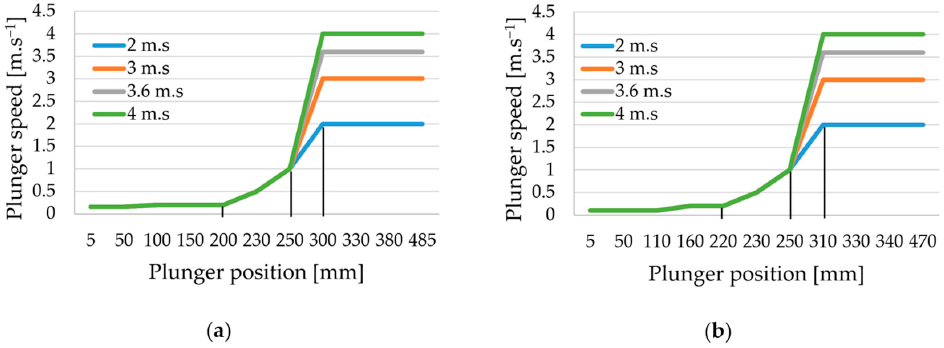
Figure 2. The dependence of the plunger speed to its position. SB 120 ( a ); SB 55 ( b ).